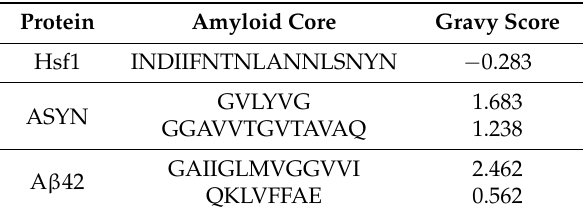
Table 1. Amyloid core hydropathicity of Hsf1 in S. cerevisiae . The GRAVY score (average hydrophobicity and hydrophilicity) was evaluated using the EXPASY ProtParam tool [40]. The GRAVY scores for the amyloid cores of α -synuclein (ASYN) and A β 42, involved in Parkinson’s and Alzheimer’s disease, respectively, are shown for comparison.